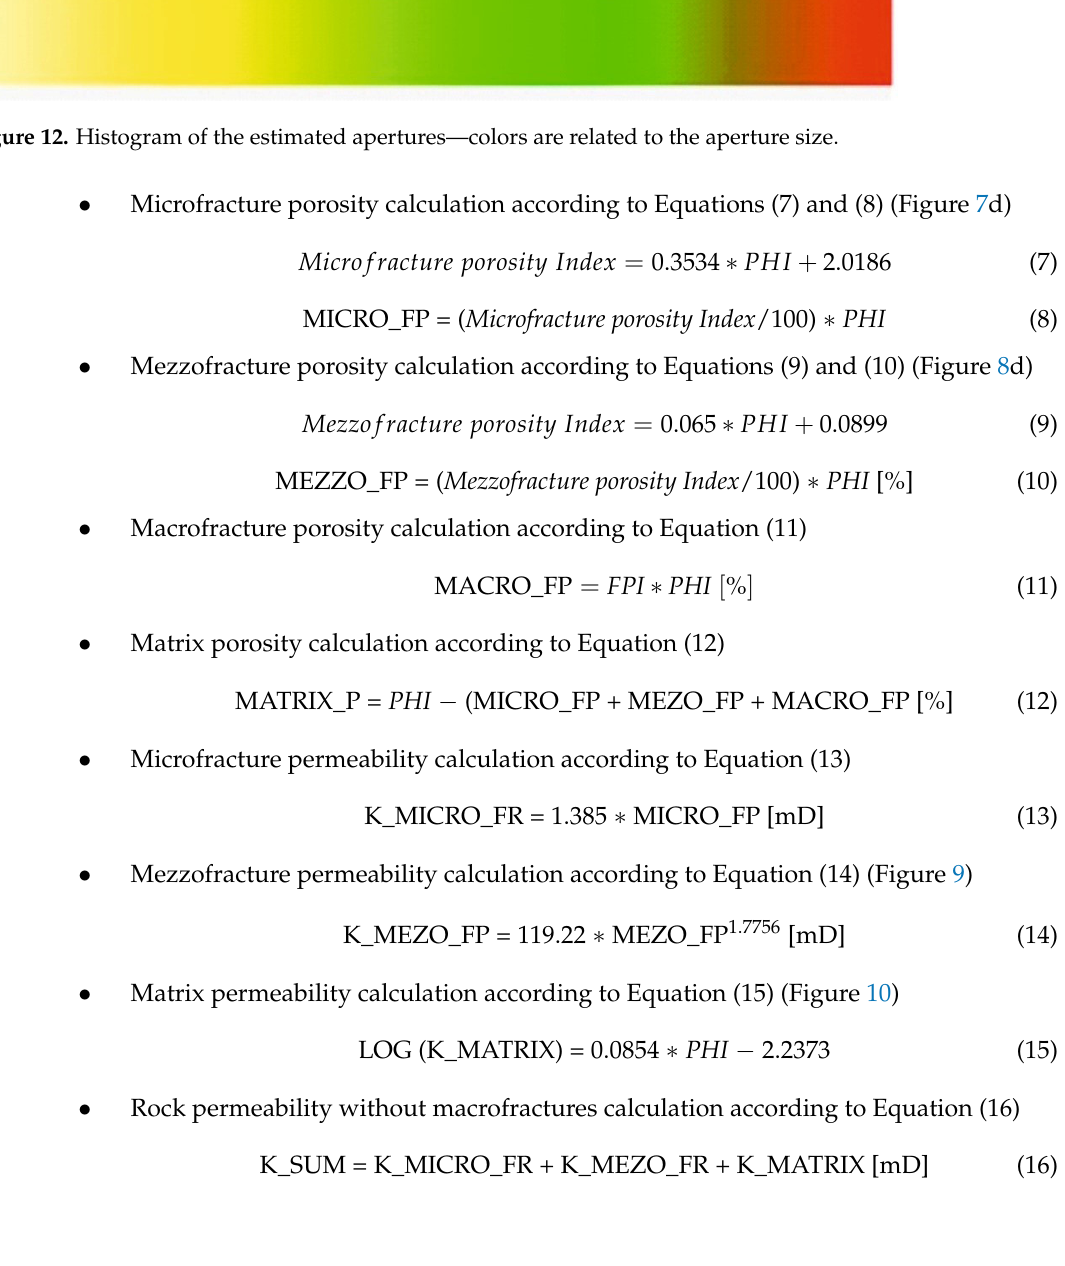
Figure 12. Histogram of the estimated apertures—colors are related to the aperture size.